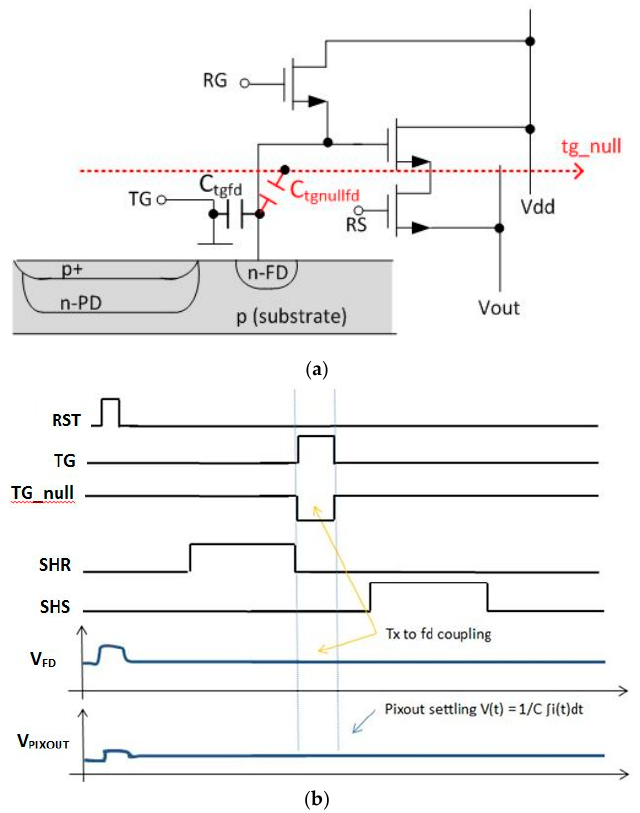
Figure 3. ( a ) New pixel schematic showing tg_null signal line used to compensate TG feed ‐ through. ( b ) New pixel readout timing diagram and output waveform; TG feed ‐ through is compensated.